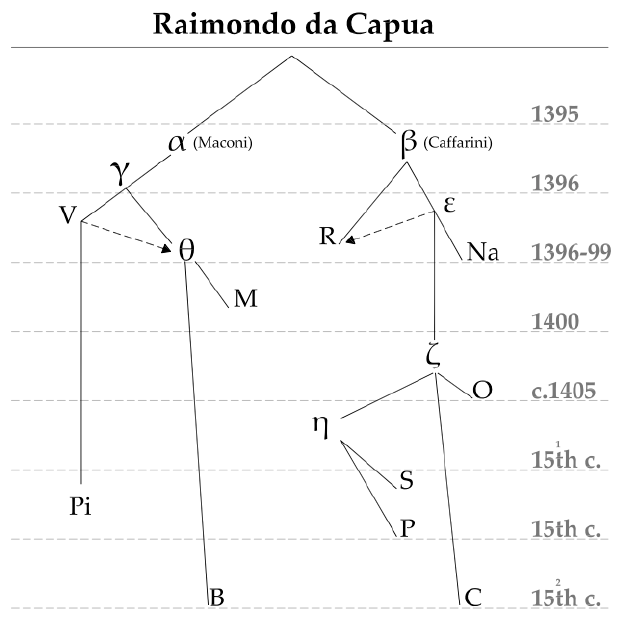
Figure 1. Stemma codicum based on (Nocentini 2013a, p. 95).